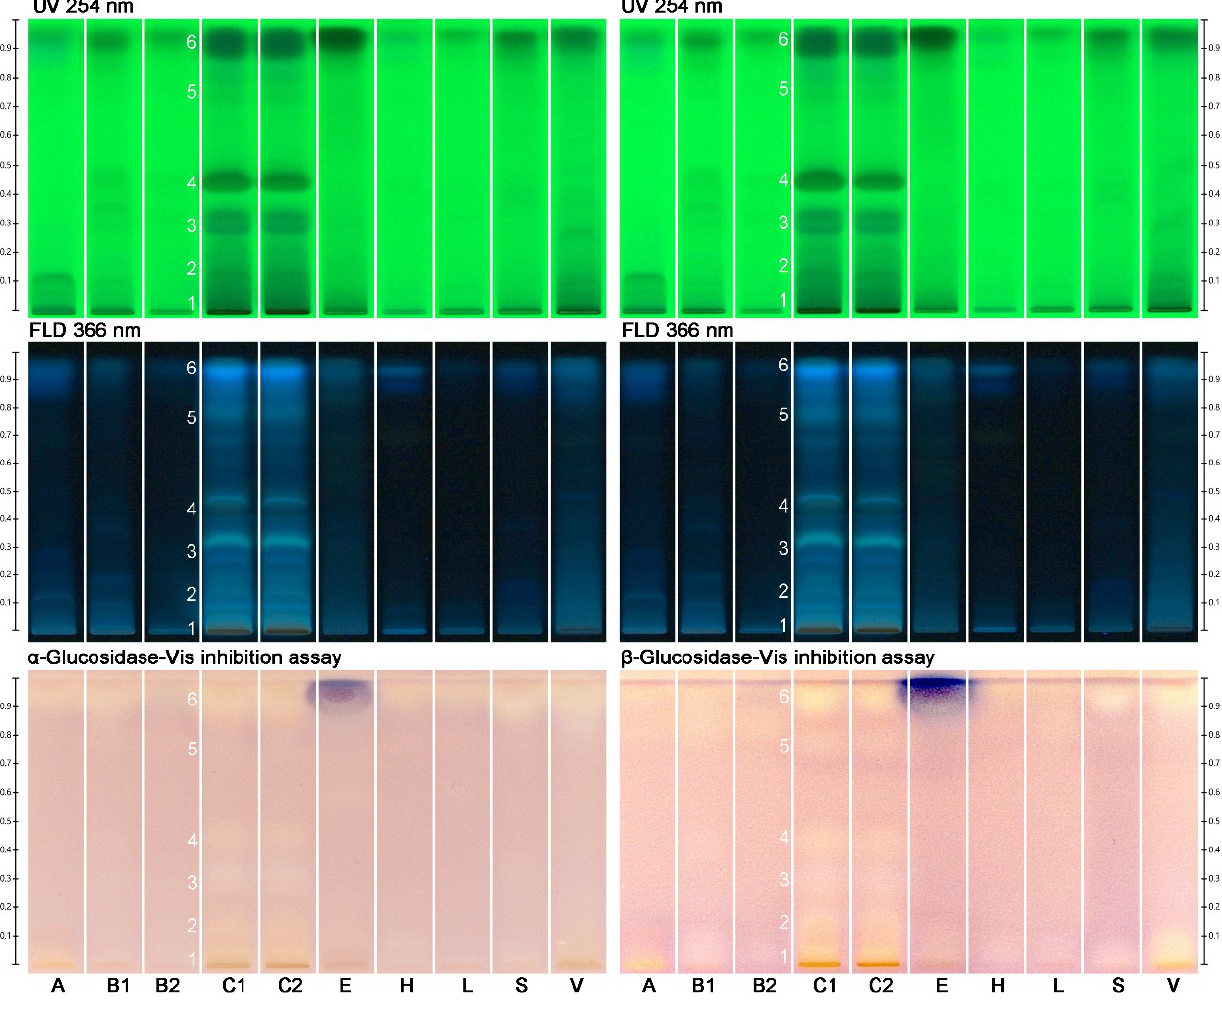
Figure 1. Physico-chemical profiling at UV 254 nm and FLD 366 nm of 10 monofloral honey extract samples (assigned as in Table 1; 3 µL/band each) on HPTLC silica gel 60 F 254 plates with ethyl acetate – methanol 3:2, V / V , as well as effect- directed profiling via the α - and β -glucosidase inhibition assays, detecting the glucosidase inhibiting zones 1 − 6 at white light illumination